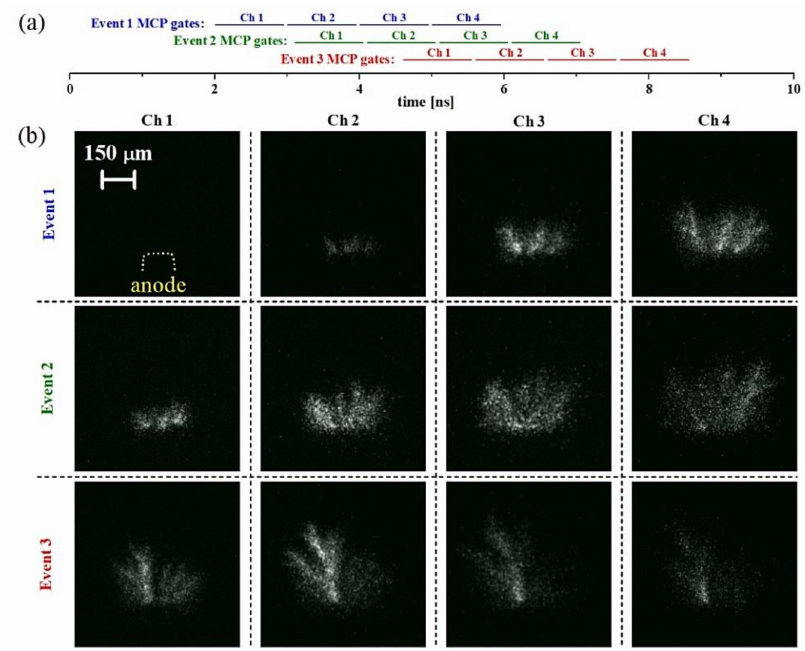
Figure 6. Case study A; image sequences obtained with the discharge emission that passes through the λ c = 532 nm interference filter. Horizontal bars in ( a ) labelled as Ch1–Ch4 illustrate the timing of the Ch1–Ch4 MCP gates with respect to the onset (time t = 0 ns) of the HV pulse. Images in panel ( b ) show the evolution of selected events during the primary HV pulse acquired by using equal Ch1–Ch4 MCP gates of 1 ns.